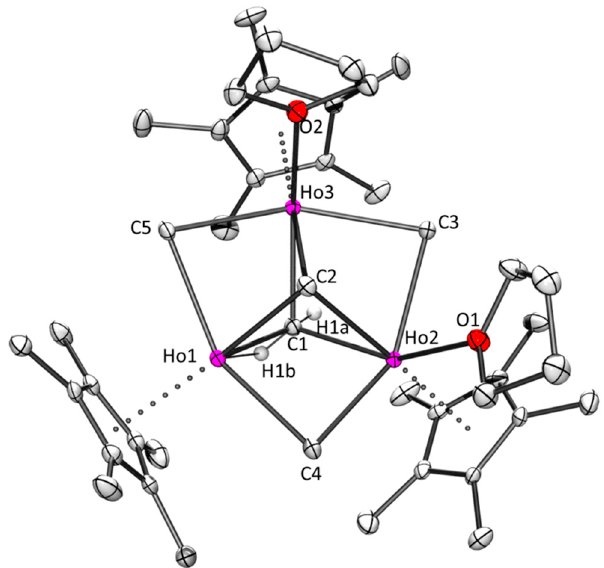
Figure 13. ORTEP view of the crystal structure of [(Cp*Ho) 3 Me 4 (CH 2 )(thf) 2 ] ( 9 Ho ). Atomic displacement parameters are set at the 50 % probability level. Hydrogen atoms are omitted for clarity except for H1a and H1b. Significant lengths (Å) and angles (°) for 9 Ho : Ho–C Cp* : 2.678(4)–2.713(4); Ho–Ct: 2.402 – 2.415; Ho–C3/4/5: 2.535(4)–2.582(5); Ho–C1: 2.275(4)–2.468(4); Ho–C2: 2.558(4)–2.764(4); Ho-O1/2: 2.571(3),